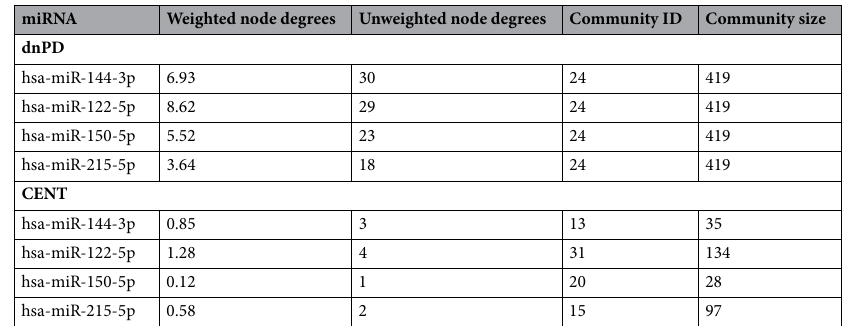
Table 2. Node degrees statistics of miRNA communities. Columns 1 and 2 show the weighted and unweighted node degrees for each miRNA of interest in the given community. Column 3 reports the community ID, a consequent number, only needed to identify the location of a given miRNA with no other meaning. Column 4 shows the dimension (number of nodes) of each of the community described in Column 3.